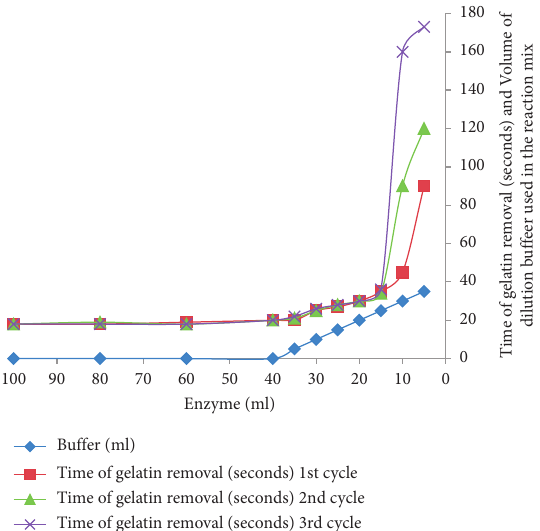
Figure 6: Effect of enzyme concentration on the time course of gelatin hydrolysis at 70 ° C and pH 7.0.